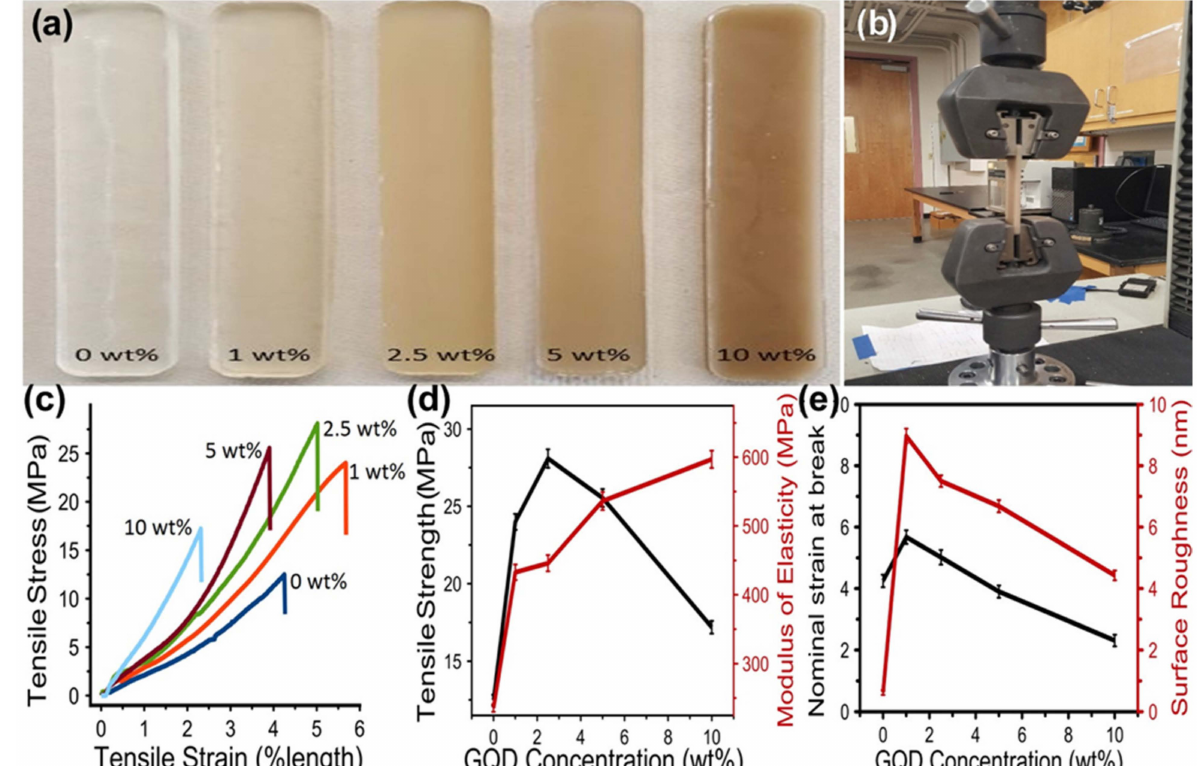
Figure 4. ( a ) Digital images of epoxy-GQD nanocomposites with various loadings of GQDs. ( b ) Instron setup for tensile test. ( c ) Stress–strain curves of various nanocomposites. ( d ) Tensile strength and modulus of elasticity against GQD concentrations, showing that the addition of GQDs made the epoxy stiffer and stronger. ( e ) Tensile strain and surface roughness of composites. Repro- duced with permission from ref.